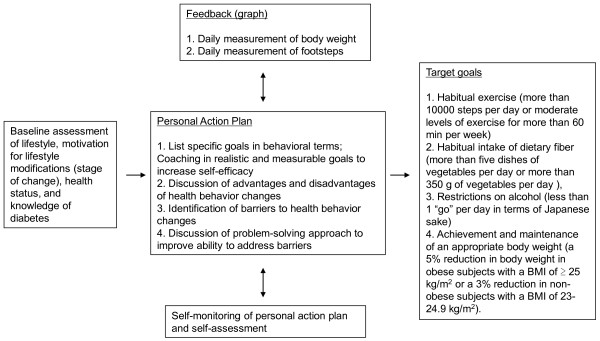
Telephone-delivered lifestyle modification support model: theory matrix.